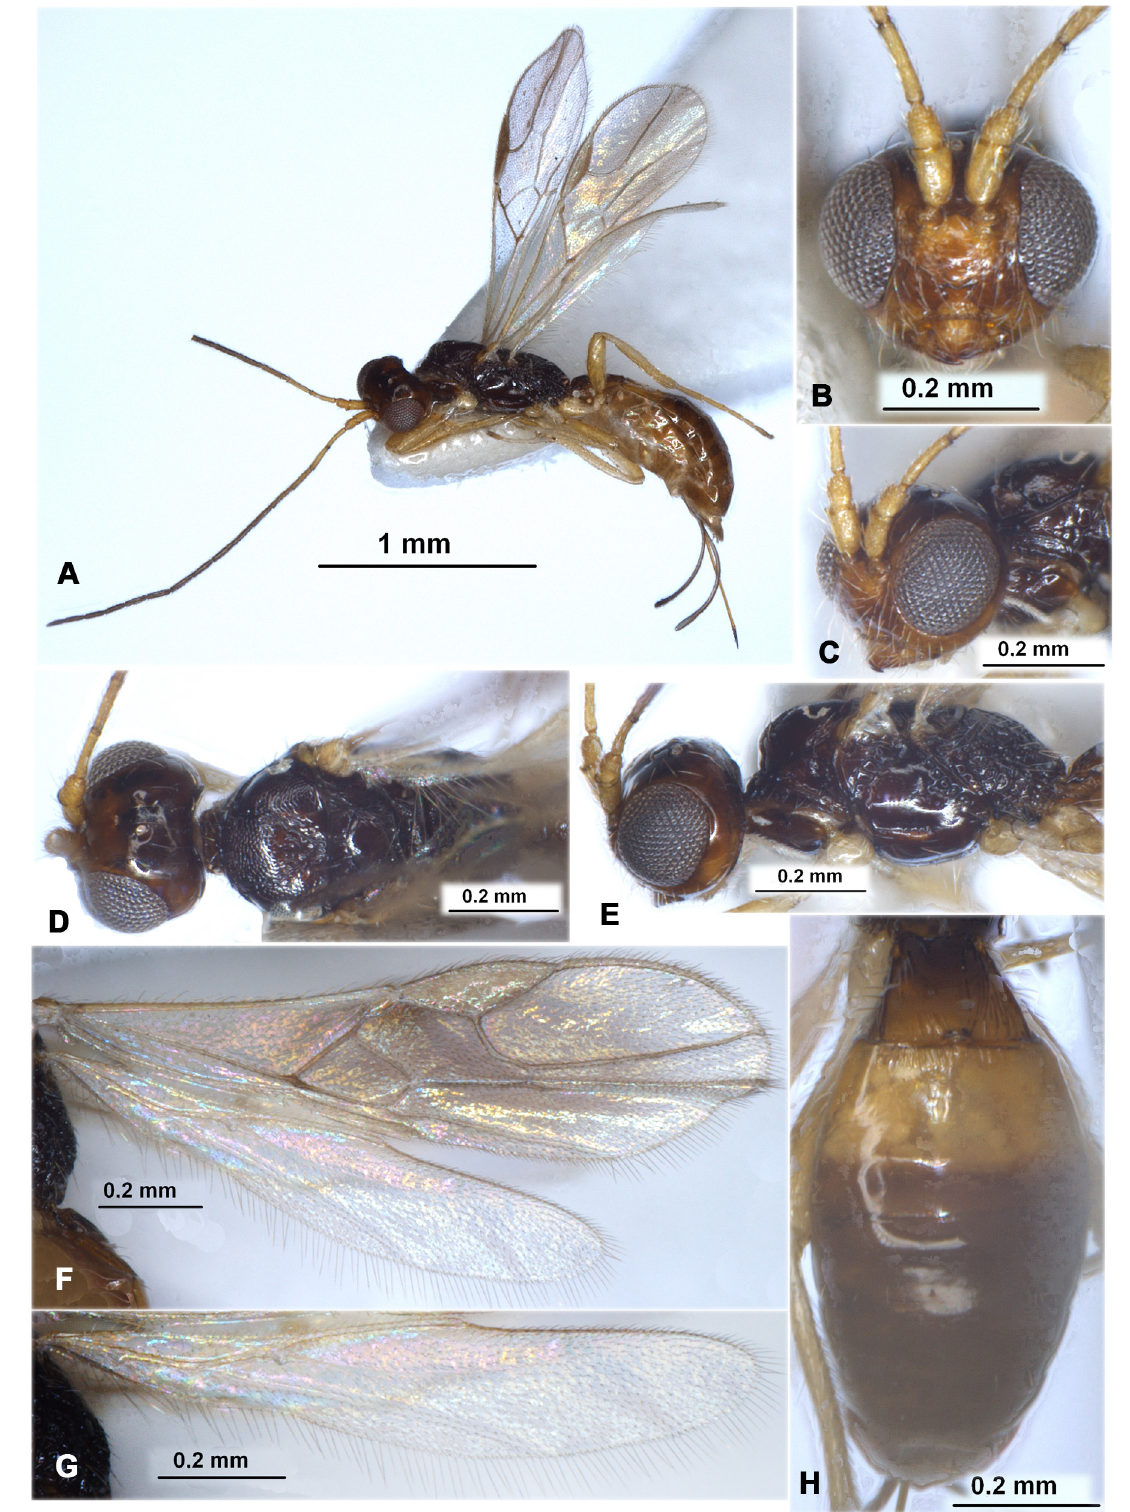
Fig. 38. Heterospilus ( Eoheterospilus ) rubrocinctus (Ashmead, 1905), ♀ (RMNH). A . Habitus, lateral view. B . Head, front view. C . Head, antero-lateral view. D . Head and mesosoma, dorsal view. E . Head and mesosoma, lateral view. F . Wings. G . Hind wing. H . Metasoma, dorsal